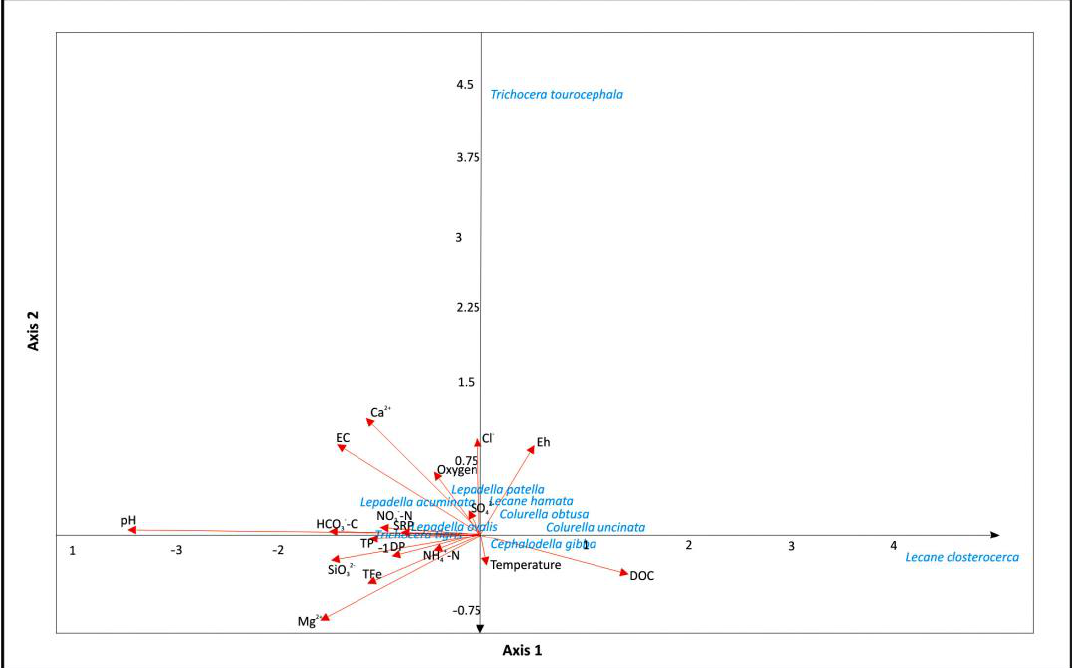
Figure 7. The impact of water quality in the springs on the most numerous species of Rotifers in the Knyszyńska Forest ( R 2 = 0.3779 and R 2 adjusted = 0.04957).